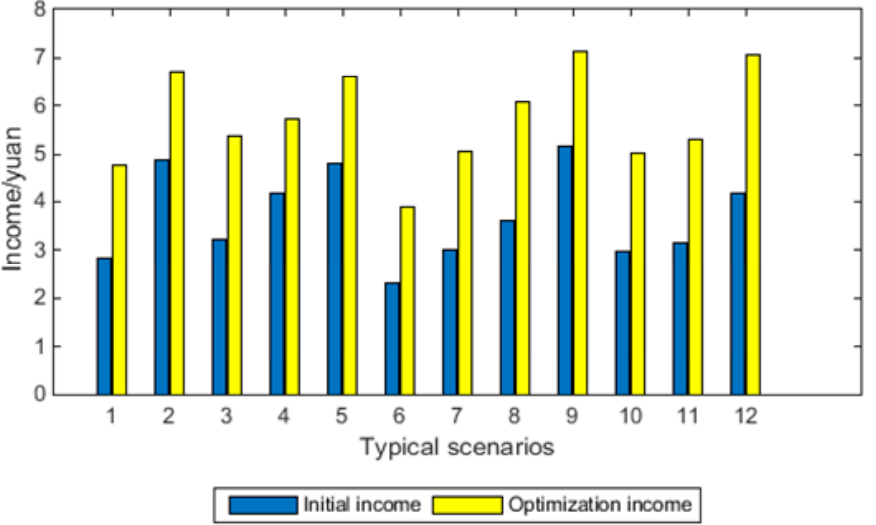
Figure 13. Virtual power plant initial revenue and optimal revenue comparison chart (10 5 yuan ).